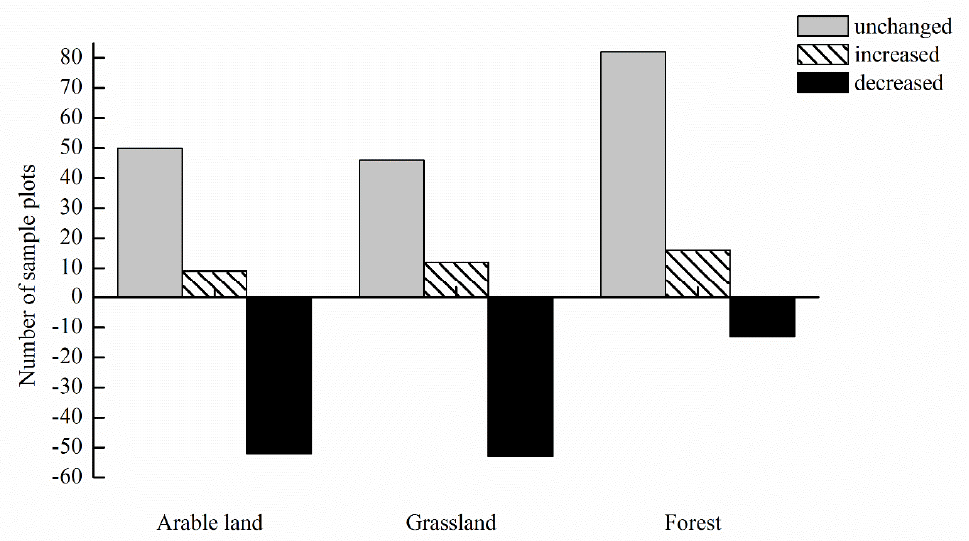
Figure 7. Change of guild species frequency at single sample plots (number of plots at which the frequency of guild representatives changed, including zero values).